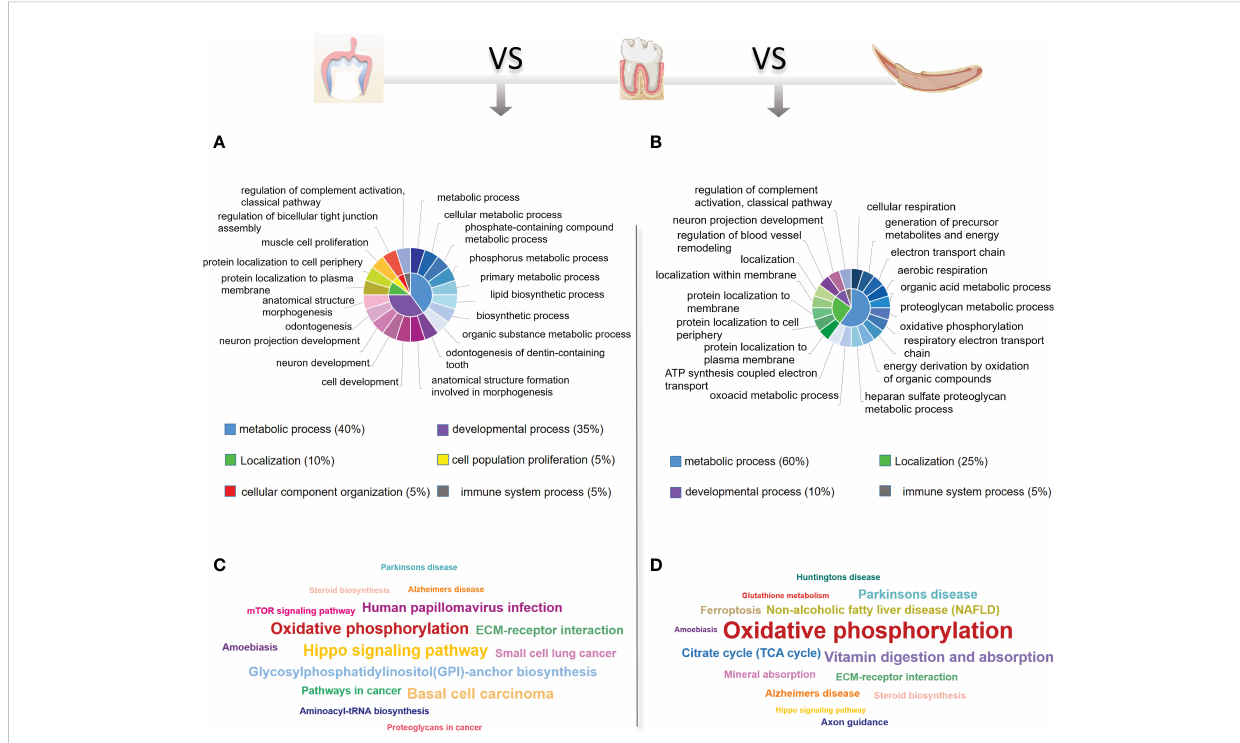
FIGURE 3 GO and KEGG database enrichment analyses were used to determine the critical pathways of the upregulated DEGs in DeP and CgP. (A, B) The top 20 biological processes in the GO enrichment analyses of the upregulated DEGs in DeP (A) and CgP (B) . The same color in the inner circle represents the same category of pathways in the outer ring, and the area size of the inner circle represents the proportion of the pathway category. (C, D) The top 15 pathways in the KEGG enrichment analyses of the upregulated DEGs in DeP (C) and CgP (D) . The size of the word in the word cloud is proportional to the -log10